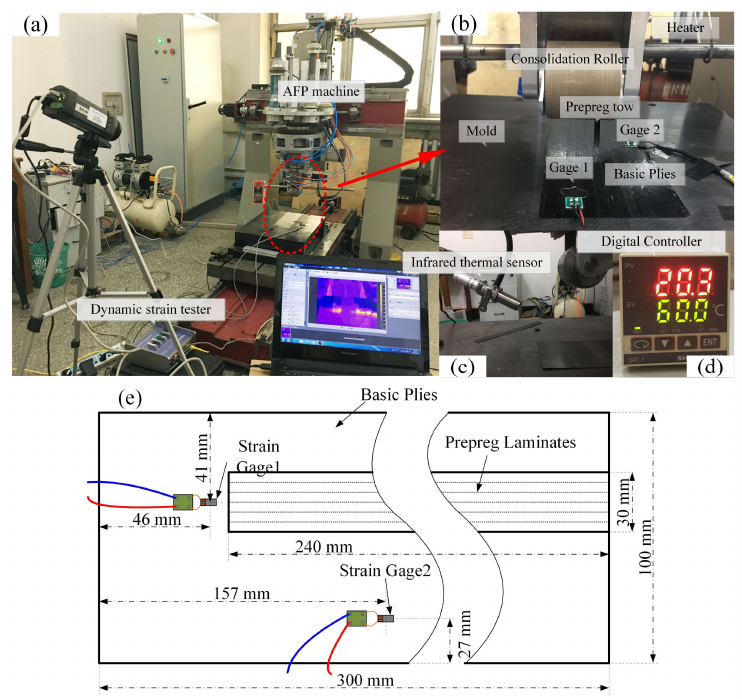
Figure 2. Twenty-seven groups of samples and curing equipment: ( a ) samples; ( b ) autoclave; ( c ) thermal sensor; ( d ) digital controller; and ( e ) sensor